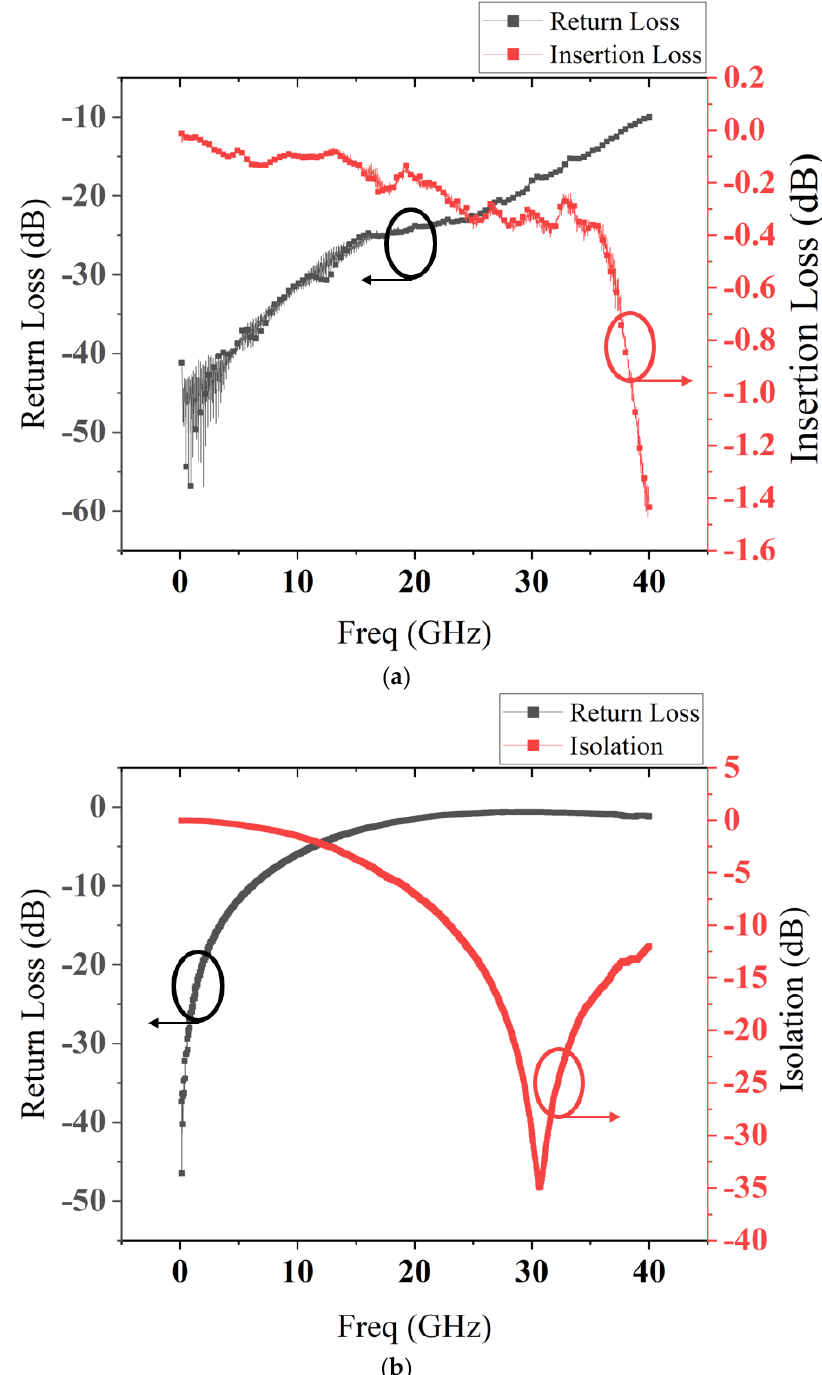
Figure 15. Measurement S parameters results of the proposed RF MEMS switch: ( a ) up-state; ( b ) down-state.